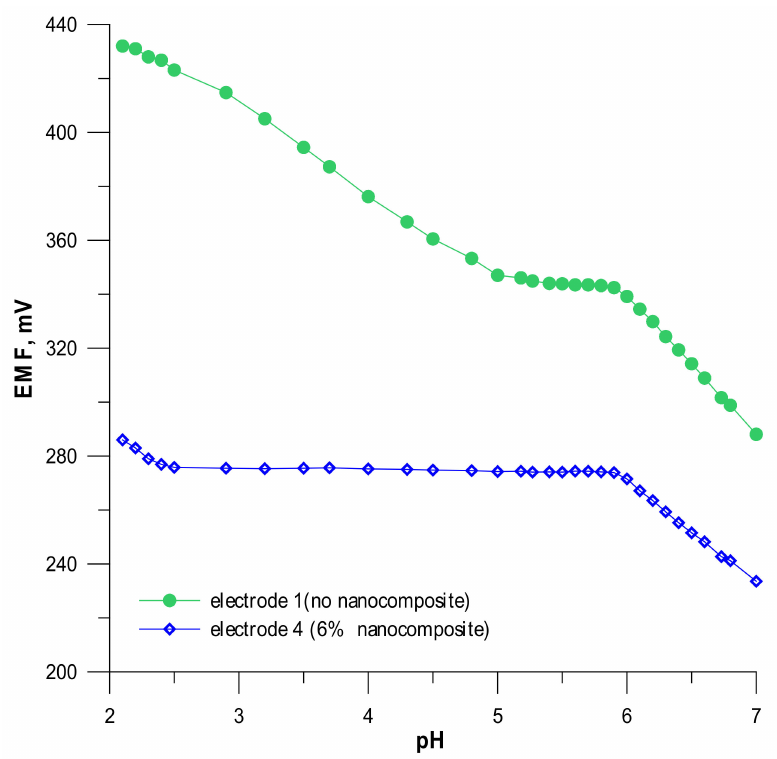
Figure 5. Dependence of electrode potential on